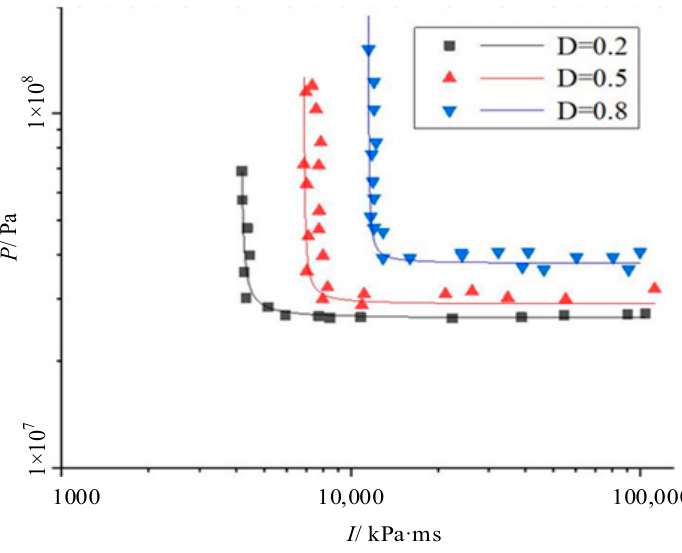
Figure 7. Fitting diagram of P-I curve.